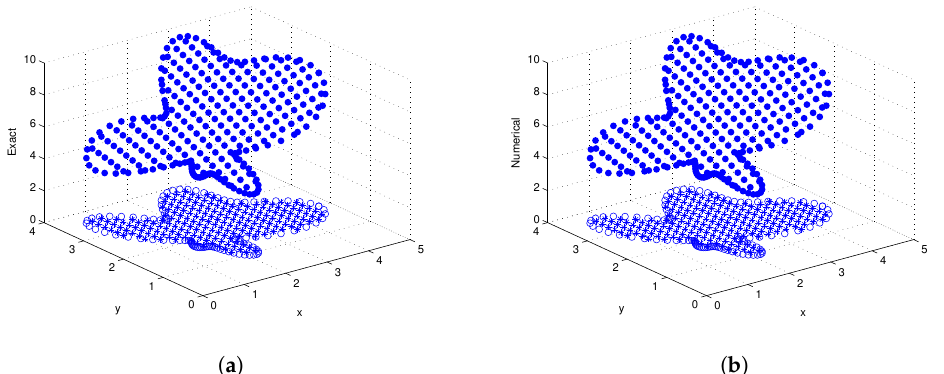
Figure 9. ( a ) Exact against ( b ) numerical solution of Ameoba-shaped domain when t = 1, δ t = 0.0001, ns = 10, M = 291 to Example 4.